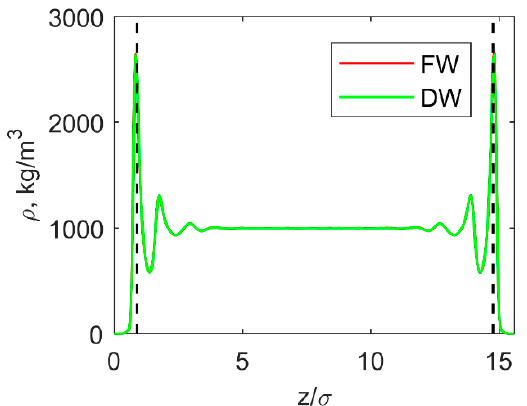
Figure 4. Water density profile along the z- axis in FW and DW simulations when the force inducing the flow is f x = 3.53 × 10 12 N/kg. Vertical dotted lines indicate σ CuO distances from the atomistic planes of the walls, which are in contact with water.